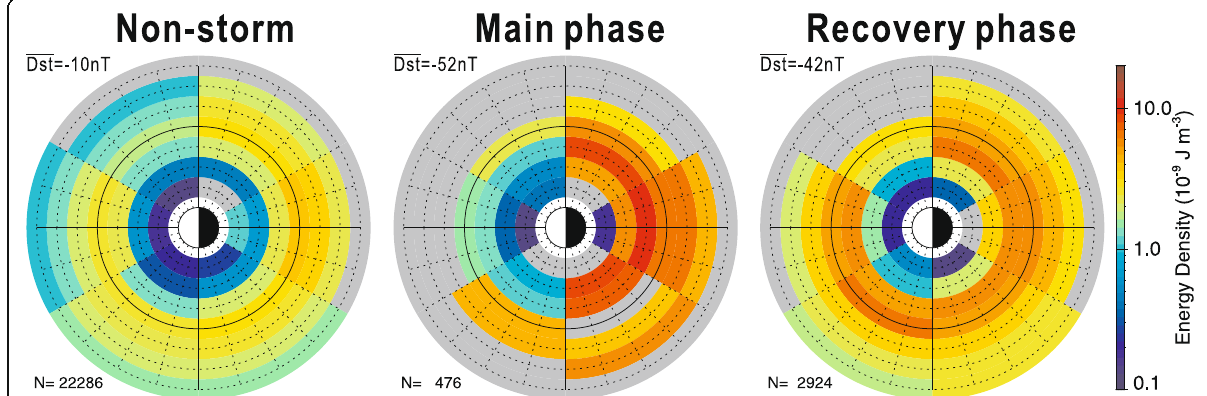
Fig. 4 Energy density of protons with energy 1 – 200 keV observed by the Polar satellite near the equatorial plane. (After Ebihara et al.